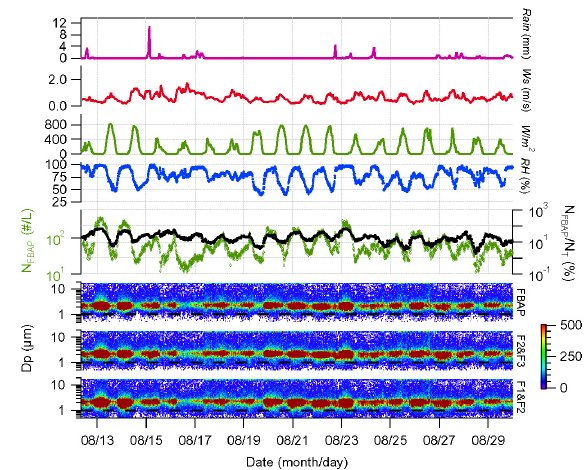
Fig. 13. WIBS-4 fluorescence data for a selected time period during summer season in comparison with meteorological data measured at the same time. The data were plotted in the same way as in Fig.